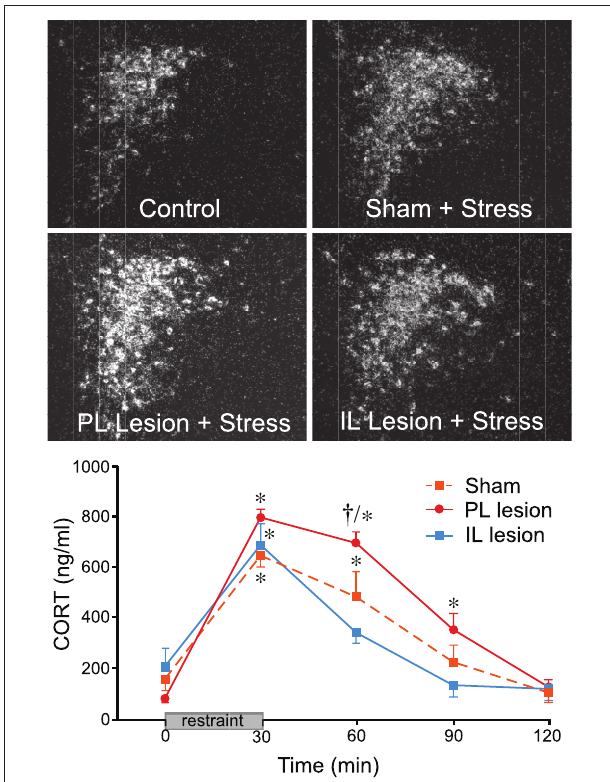
FIGURE 1 | Top: Darkfield photomicrographs showing corticotropin-releasing factor (CRF) mRNA expression in the paraventricular nucleus of the hypothalamus (PVH) as a function treatment condition. Restraint stress results in a marked increase in CRF mRNA expression in the PVH dorsal medial parvicellular subdivision of intact animals, which is enhanced in prelimbic (PL)-lesioned rats. No such enhancement of stress-induced CRF mRNA expression was seen in infralimbic (IL)-lesioned animals. Bottom: Stress exposure also significantly increases plasma corticosterone (CORT) levels in sham-lesioned animals. PL lesions result in a prolonged increase in stress-induced plasma CORT, while IL-lesioned animals show a more rapid recovery to pre-stress levels. ∗ Differs significantly from basal (0min) values from within each group, p < 0 . 05; † Differs significantly from sham-lesioned animals for a given time point, p < 0 . 01. Data are from Radley et al. (2006a).